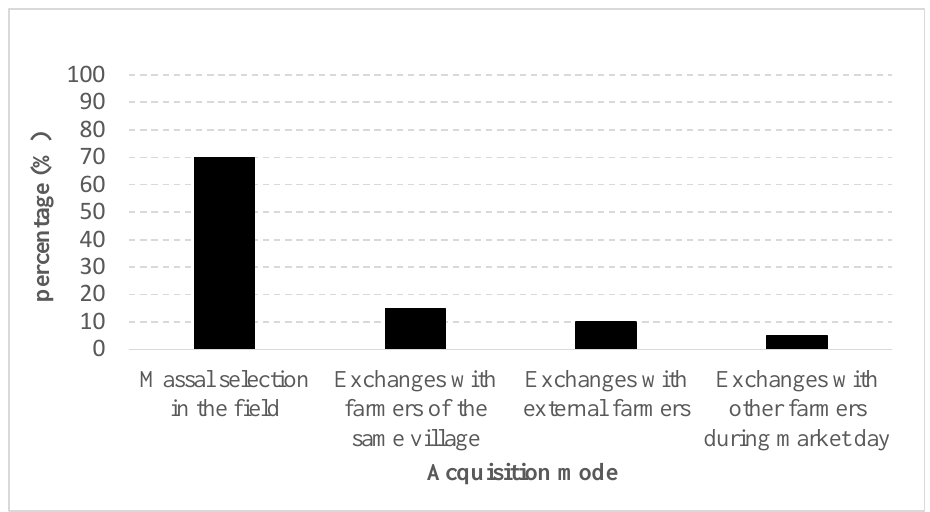
Figure 10. Mode of acquisition of sorghum seeds in flood recession farming in Yaguine, Gory, and Foungou from the 2013/2014 to the 2015/2016 cropping season.